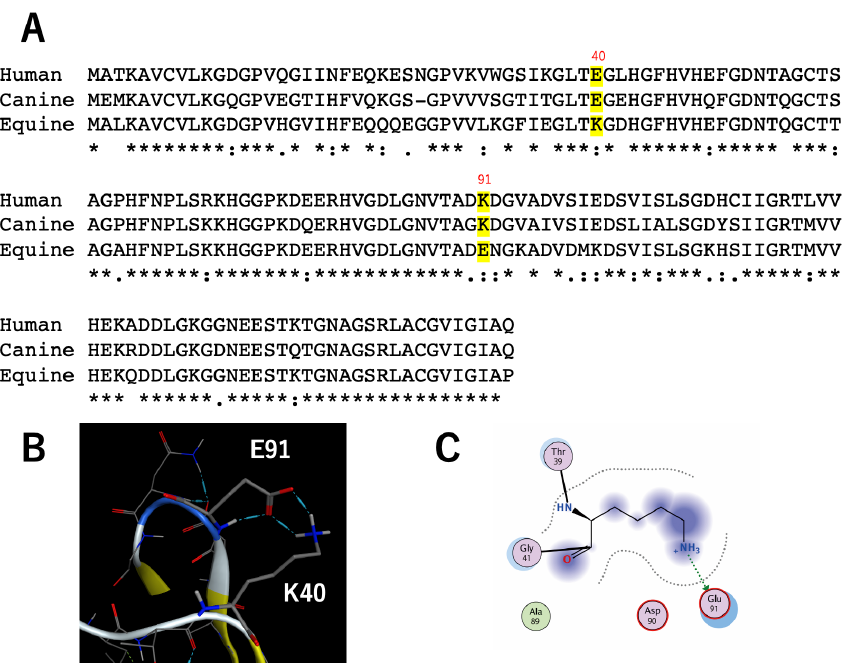
Figure 7. ( A ). Sequential alignment of human, canine, and equine SOD1s. ( B ). Close-up displays of the region around residue 40 of equine SOD1 homology model. The locations of K40 and E91 are noted. The interactions are shown by blue dotted lines. ( C ). MOE interaction map of residue 40 of the equine SOD1 homology model.